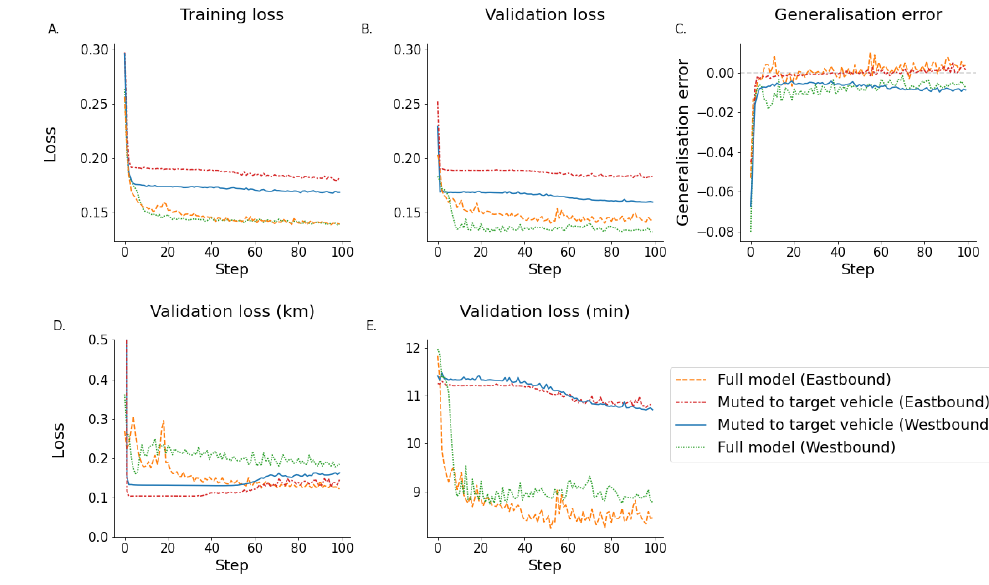
Figure 8. These figures show the model mutedto the target vehicle itself thus removing all external information. This is compared to network-based model clearly showing that the performance is reduced if the model does not have access to any external data. ( A ) shows the training loss. ( B ) shows the validation loss. ( C ) shows the generalisation error calculated by subtracting the training error from the testing error. ( D ) shows the estimated validation error in km. ( E ) shows the estimated validation loss in minutes. (Note that subfigure ( D ) has a truncated y axis for illustration purposes).